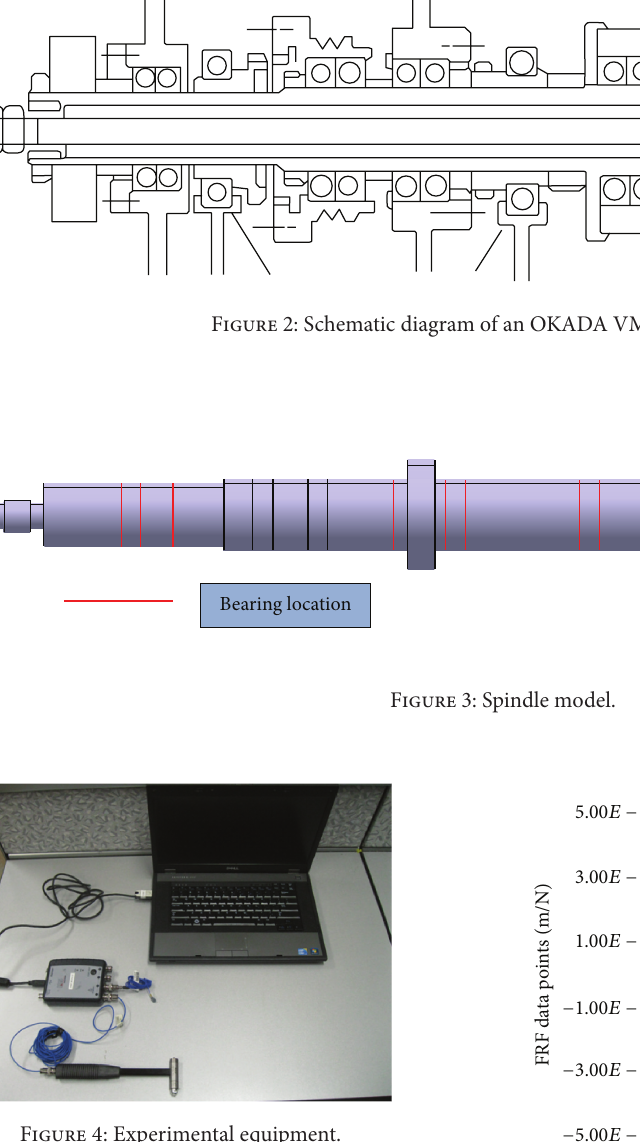
Figure 4: Experimental equipment.